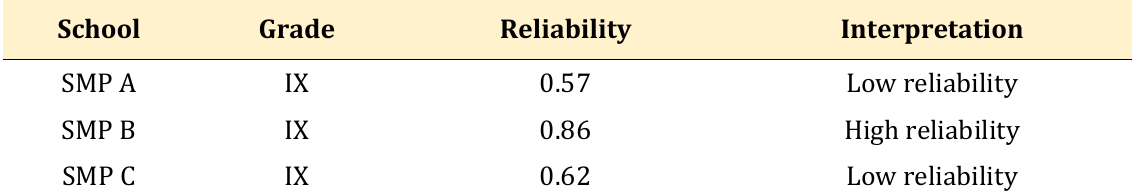
Table 2. Reliability of the